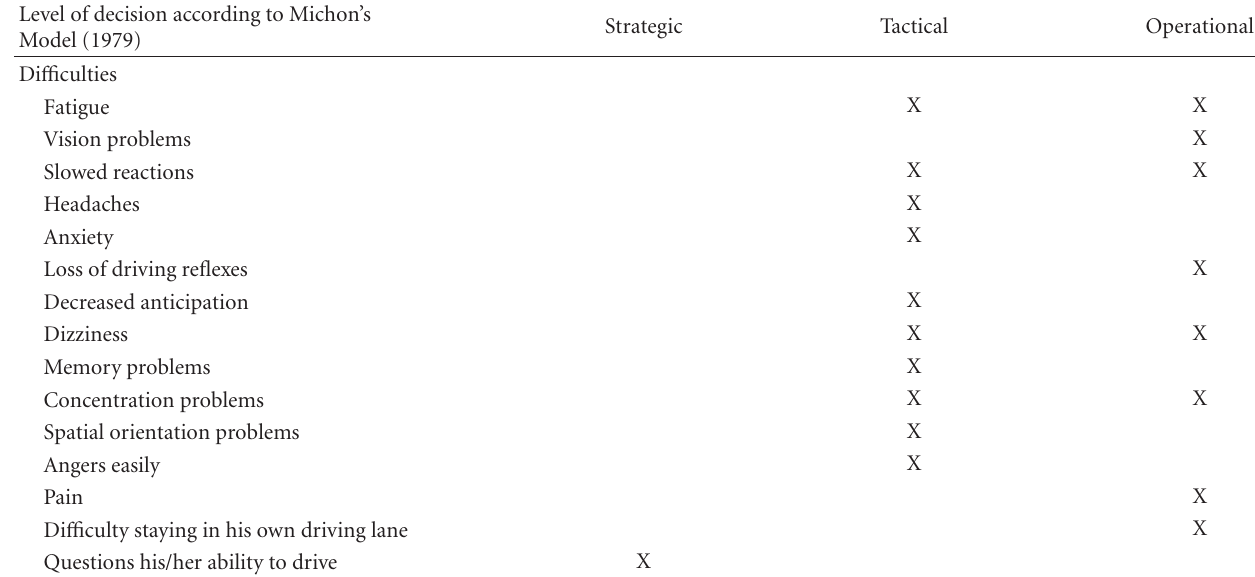
Table 4: Analysis of perceived driving di ffi culties according to the a ff ected level of decision making based on Michon’s model of car driving (1979,